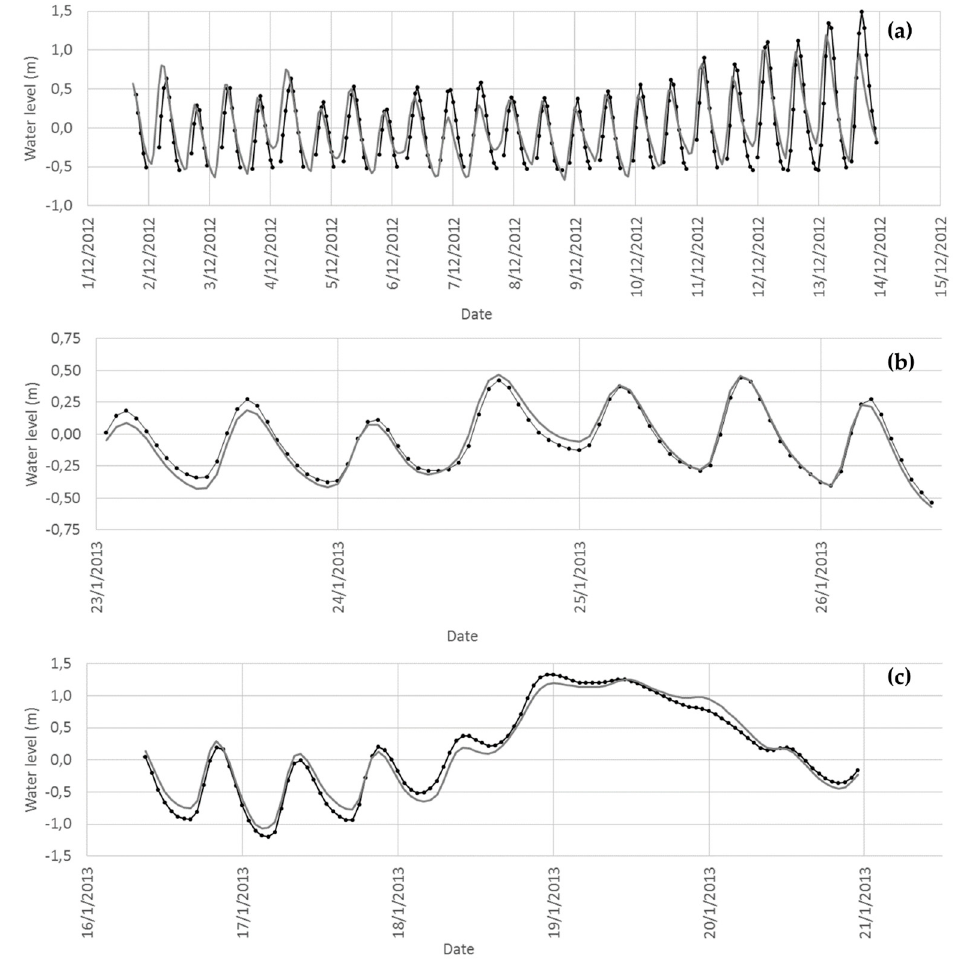
Figure 6. Water level time series at station VP5. Field data (black dotted line) and numerical data (continuous grey line). ( a ) Scenario S2. Low flow rate; ( b ) Scenario S3. Medium flow rate; and ( c ) Scenario S3. High flow rate.